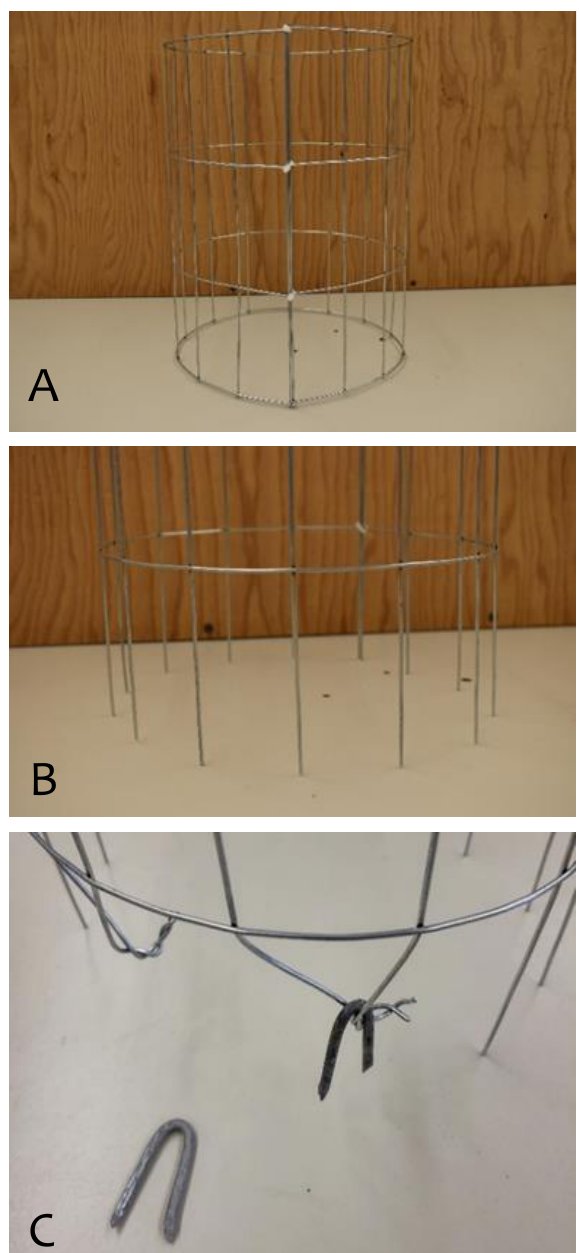
Figure 2. Exclosure frame, without any external mesh covering. (A) Exclosure frame assembled with zip ties, (B) Exclosures bottom horizontal support cut for integrated stakes, (C) in the case of hard ground, use of fencing staples may be